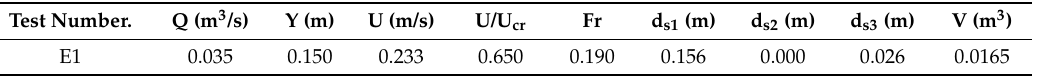
Table 1. Specifications and results of Karami, Basser, Ardeshir, and Hosseini [14] simulation. Test Number.